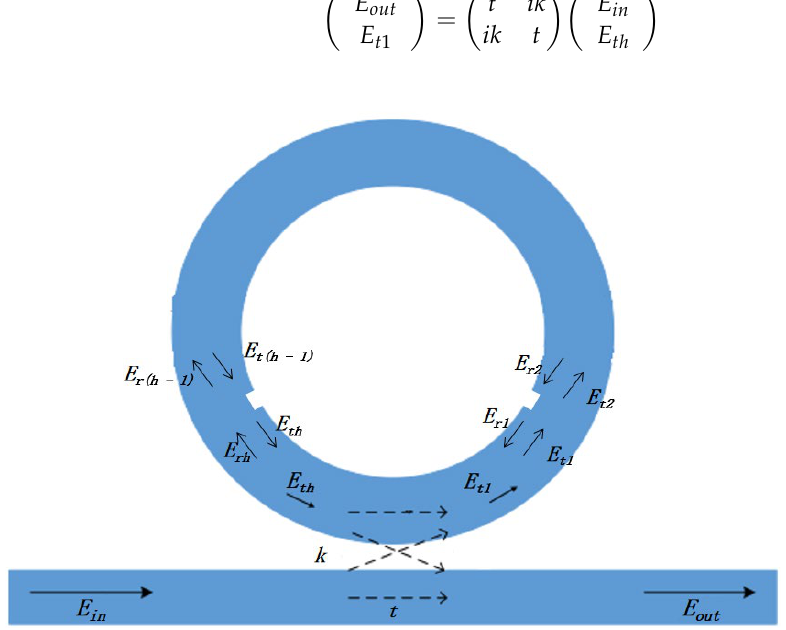
Figure 2. Transmission schematic diagram. Equation (3) represents the transmission between the busbar waveguide and the microring, where E out and E in are the intensities of the output light and input light, respec- tively; E t1 is the transmitted light intensity when the resonant light passes through the first grating tooth; and E th is the resonant light transmission intensity after passing through the last grating tooth. Considering only the transmission of light in the first and second grating teeth, the transmission matrix can be written as